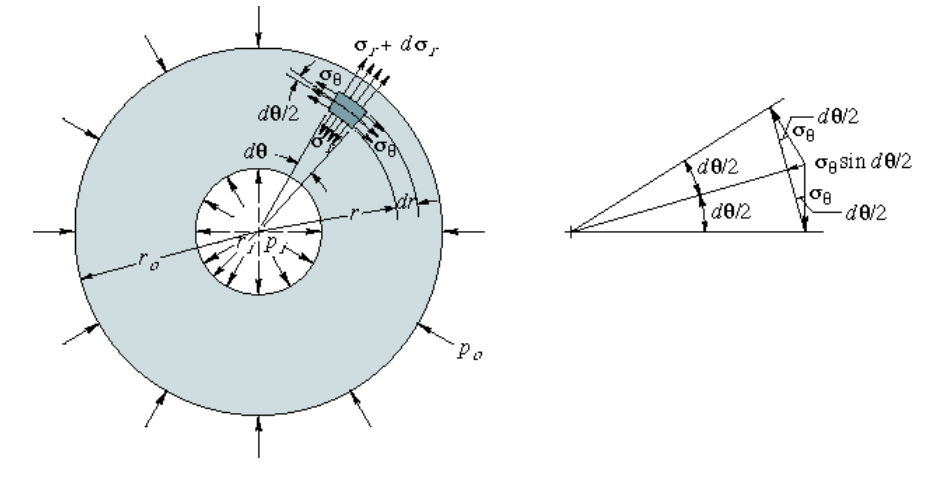
Figure 1. Stress diagram: thick-walled